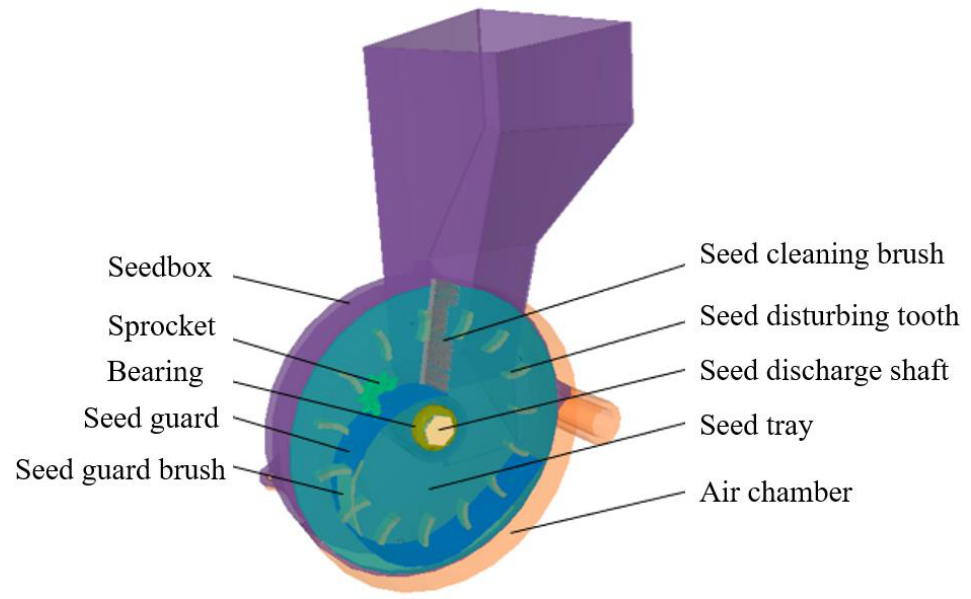
Figure 4. Schematic diagram of the disturbance air suction garlic seed metering